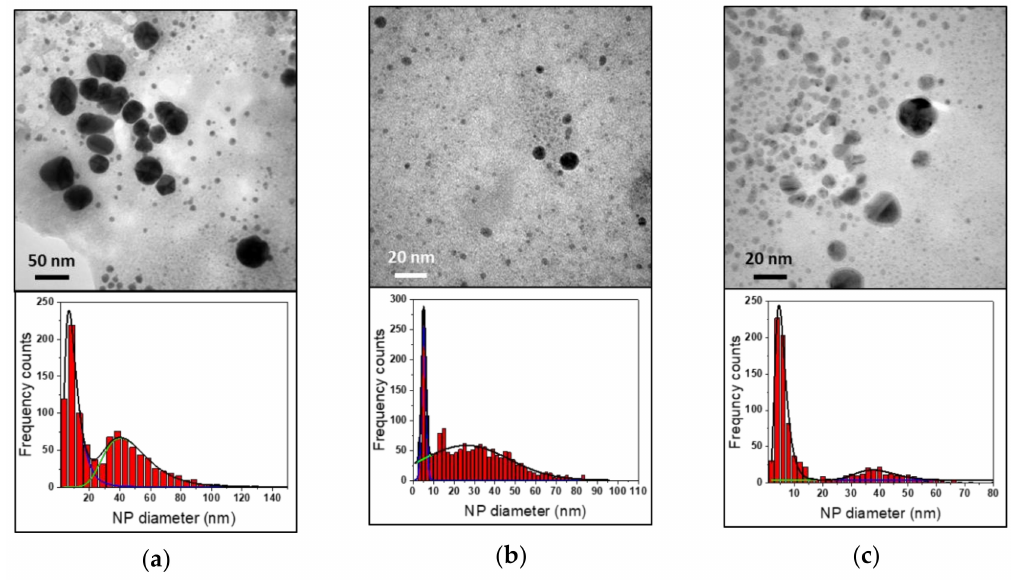
Figure7. TEMimagesofAuNPssynthesizedwithAISI430atthreedi ff erentreactiontimes. ( a )5minutes; ( b ) 15 minutes; ( c ) 30 minutes.